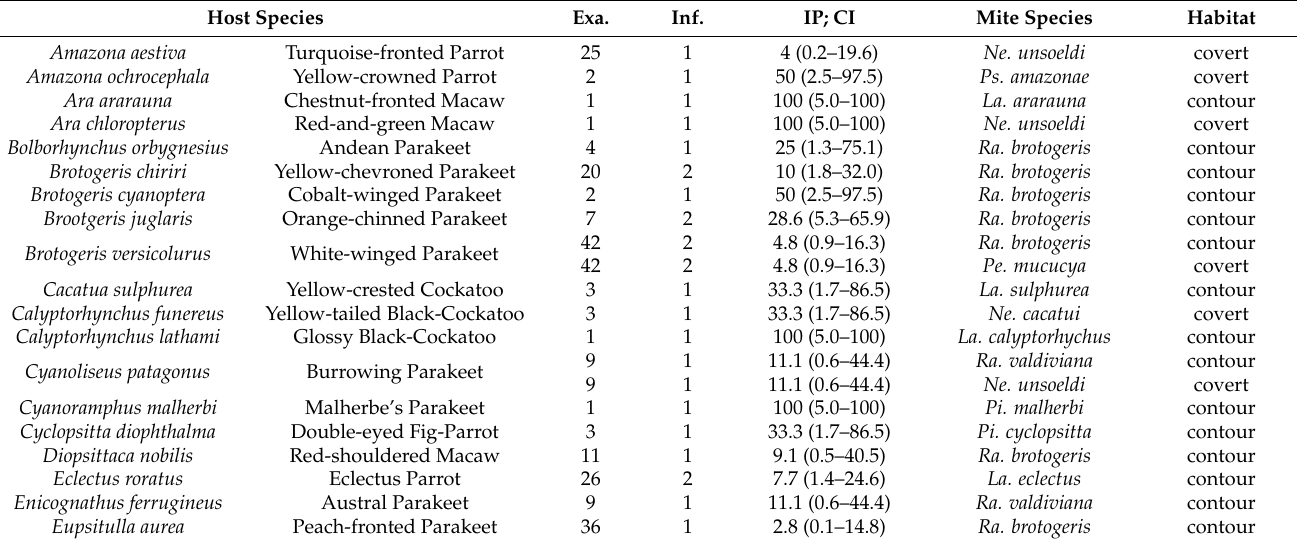
Table 2. Host species infested by quill mites with habitat and the index of prevalence (IP) and 95% confidence interval (CI, Sterne’s